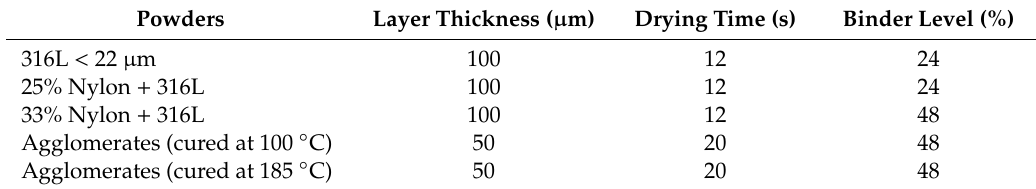
Table 5. Powders and printing parameters used in Ziaee et al. [106].